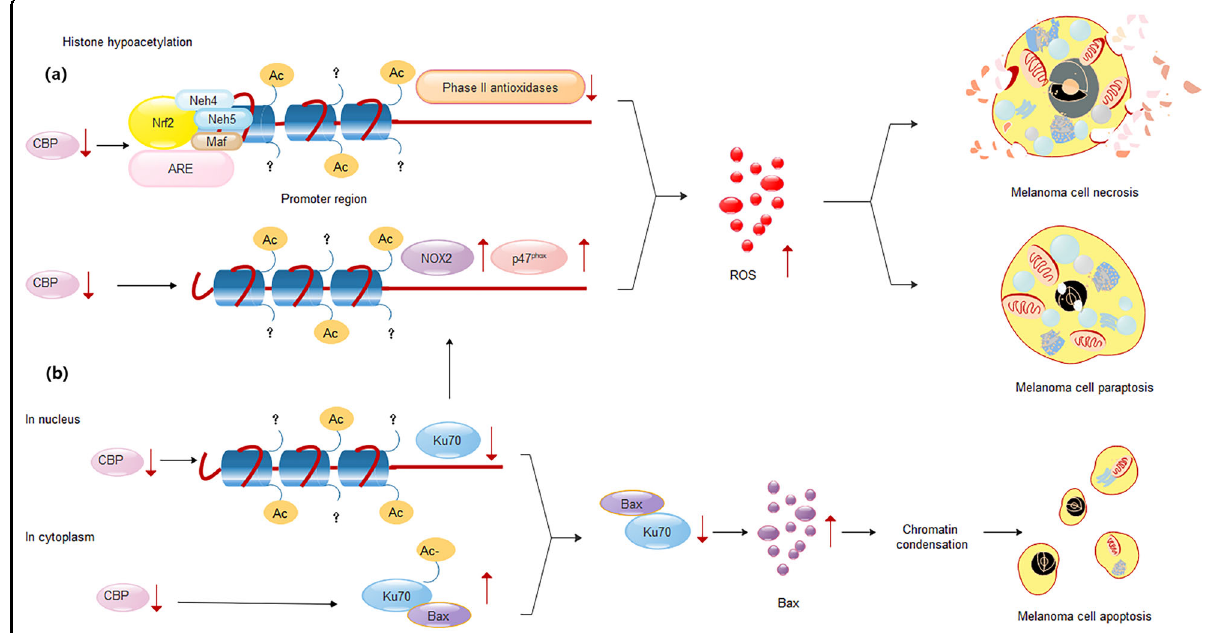
Fig. 8 The gene regulatory network composed of CBP, Ku70, and NOX2 for the prevention of necrosis, paraptosis, and apoptosis in human melanoma. a The transcriptions of the CBP, Ku70, and NOX2 are responsible for ROS-related necrosis and paraptosis; b transcriptions of the CBP, Ku70, and Bax are responsible for the